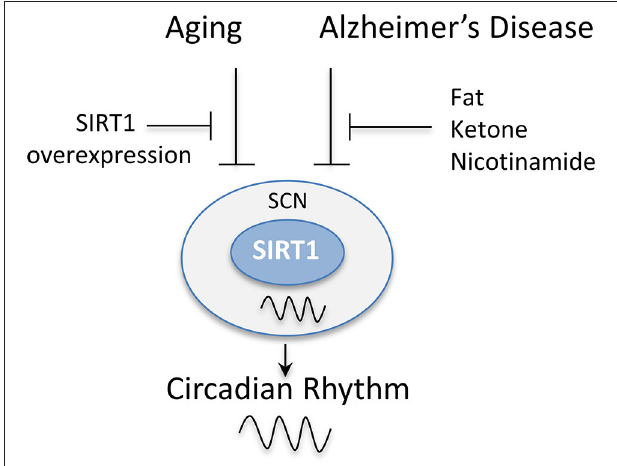
FIGURE 5 | SIRT1 levels in the suprachiasmatic nucleus (SCN) are disrupted by aging and Alzheimer’s disease. The rhythmic expression of SIRT1 in the SCN has been reported to be disrupted in animal models of aging and Alzheimer’s disease. This, in turn, disrupts the circadian expression of clock genes causing a disruption in the activity patterns of mice and their entrainment to light. The overexpression of SIRT1 protected mice from these age-dependent effects. Similarly, the administration of fat, ketone bodies, or nicotinamide rescued the circadian expression of clock genes in Alzheimer’s disease mouse models and restored their locomotor